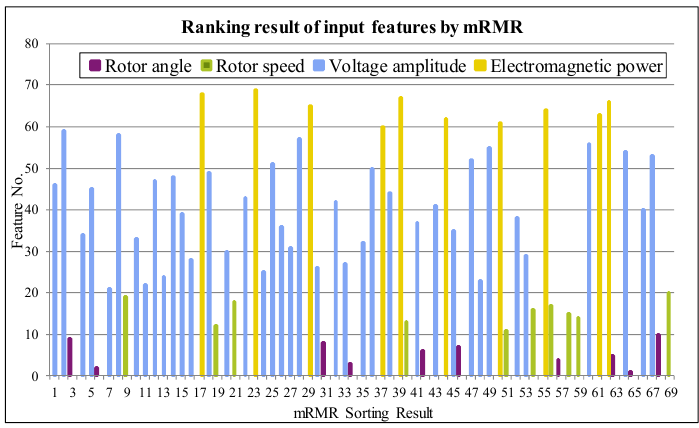
Figure 10. Sorting result of input features by mRMR.